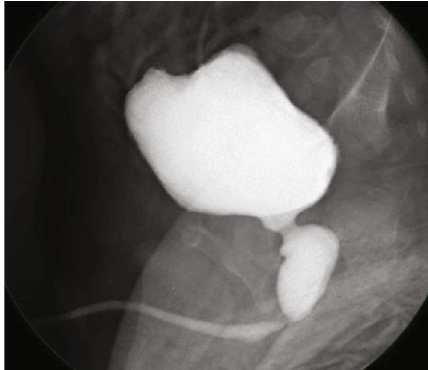
Figure 2: Dilated posterior urethra on MCUG.